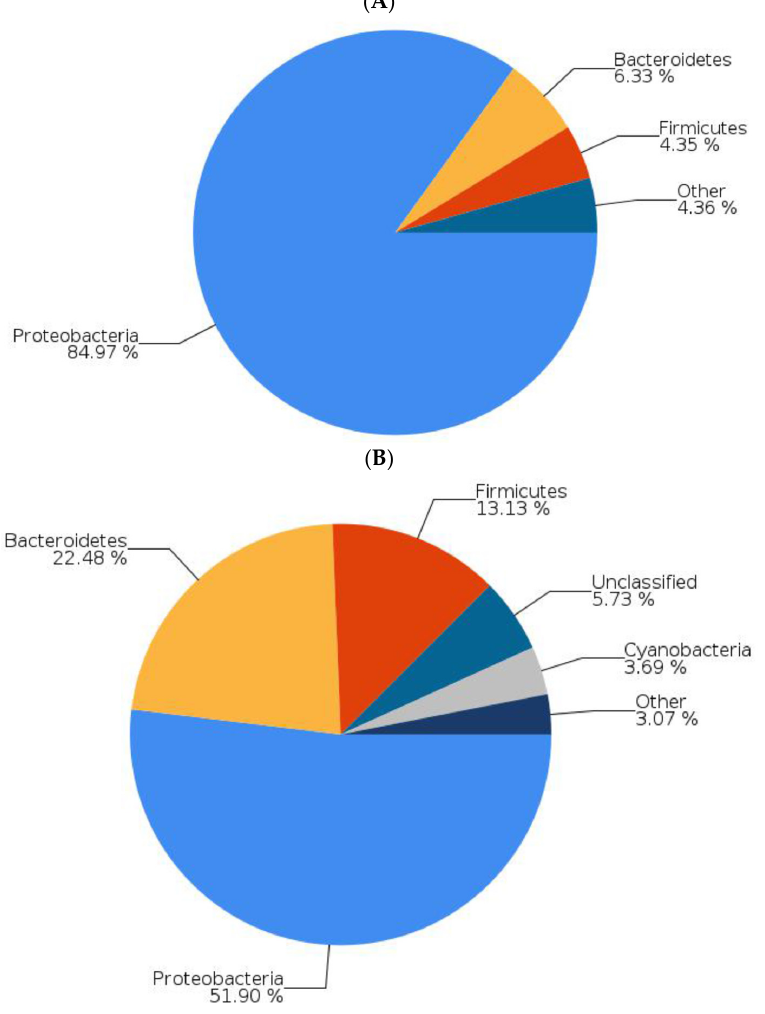
Figure 3. Bacterial structure of different phyla in the gut of zebrafish fed a normal diet ( A ) or fed soybean tempeh fermented with Rhizopus oryzae MH-001. ( B ) Data were obtained by next-generation sequencing. Data under 1% not shown.